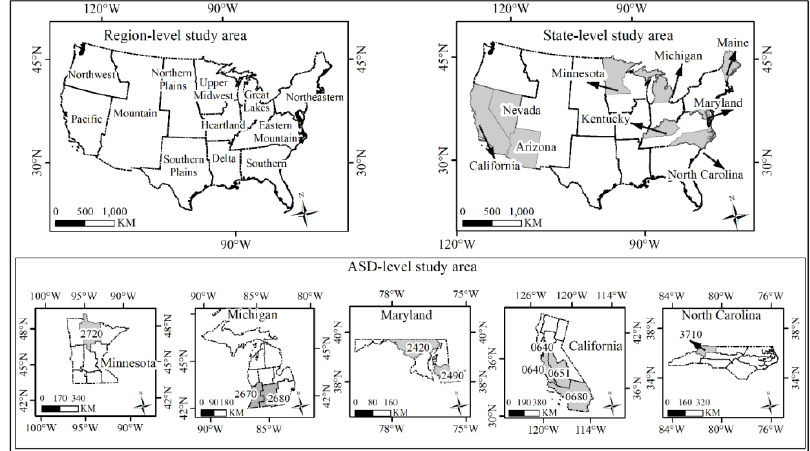
Figure 1. Study sites. Note that the region-level study sites consist of all twelve regions. The state-level study sites consist of nine states. The Agriculture Statistic District (ASD)-level study sites consist of nine ASDs. The number in ASD level study area represents the identify number of the ASD for marking different ASDs. For example, 2720 in the Figure 1 represents the study site of ASD2720. Table 1. Landscape pattern for study sites at different levels. TA, NP and PLAND, respectively, represents the total area, the number of fields, and the proportion of crop in the landscape scenarios. Patch-Per-Unit area (PPU) measures the fragmentation of the study sites. Note that PPU were performed in kilometer square (km 2 ) in this paper. TA (km 2 ) NP PLAND Mean Size of Fields (km 2 )